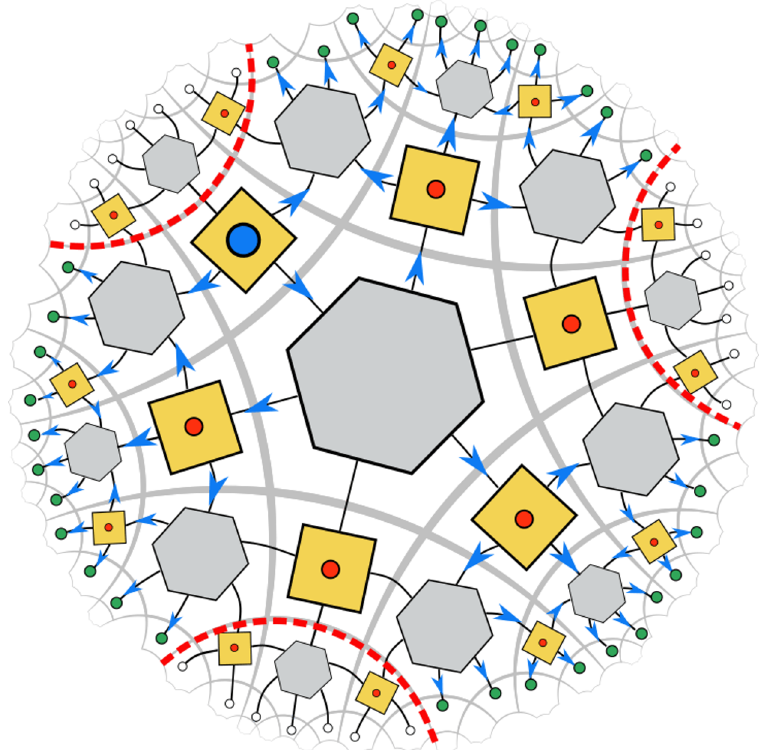
Figure 20. Representation of the same bulk operator over three boundary